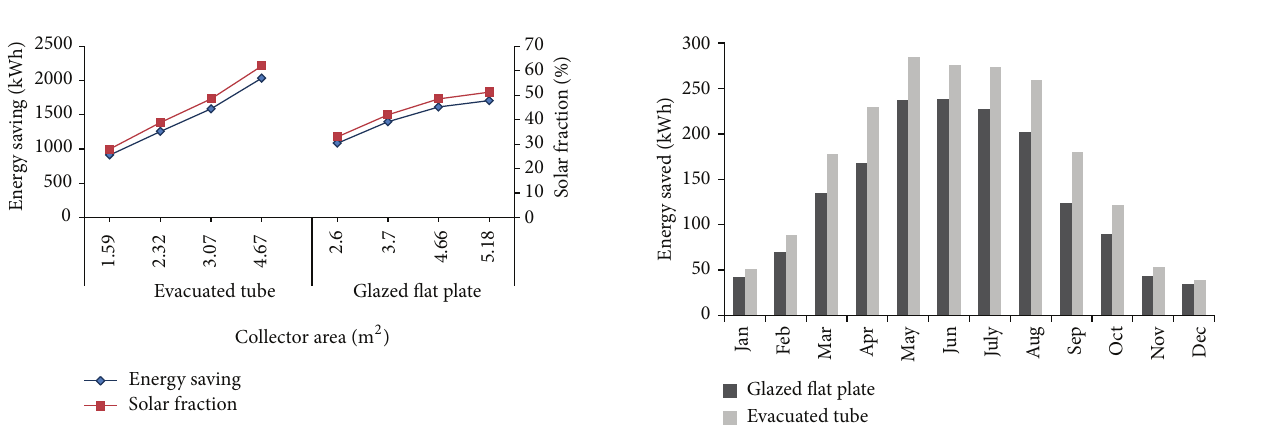
Figure 6: Monthly auxiliary (electric) energy saving for 4.66 m 2 collector area for each type of collectors.